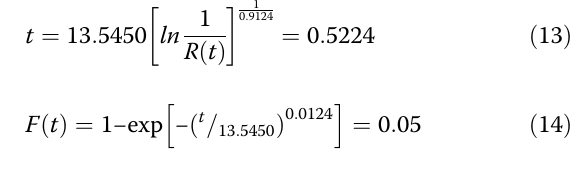
Table 3 The reliability characteristic functions of each subsystem Subsystem Reliability function Failure rate function Average life (days) Running gear